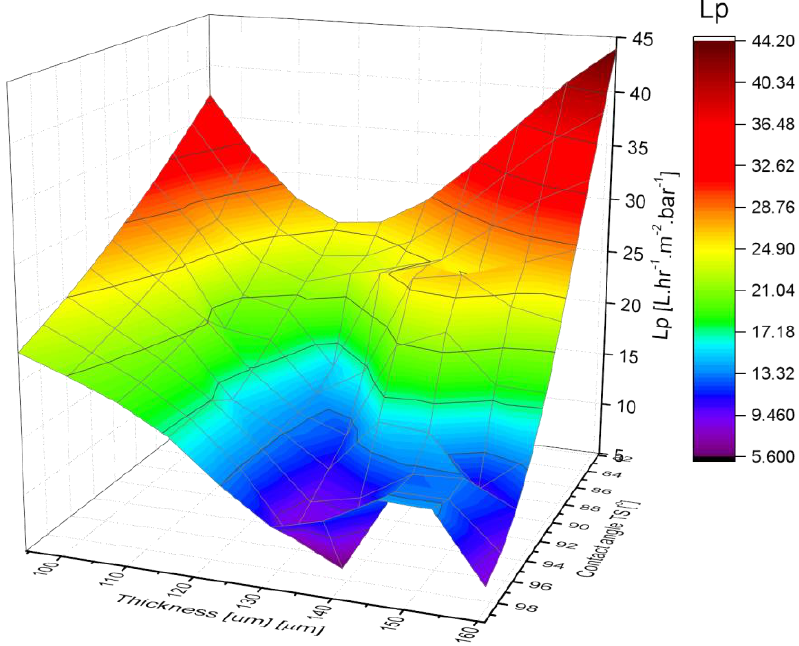
Figure 14. 3D graph of PVDF membranes’ water permeability as a function of thickness and contact angle.